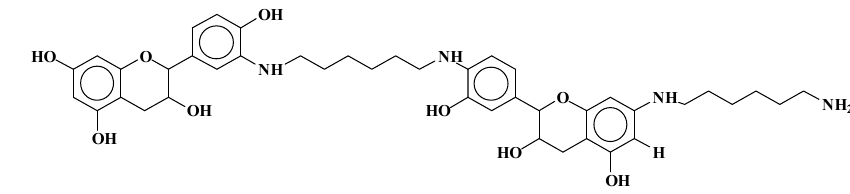
Figure 9. Example of covalent bonds dimer at 758 Da.